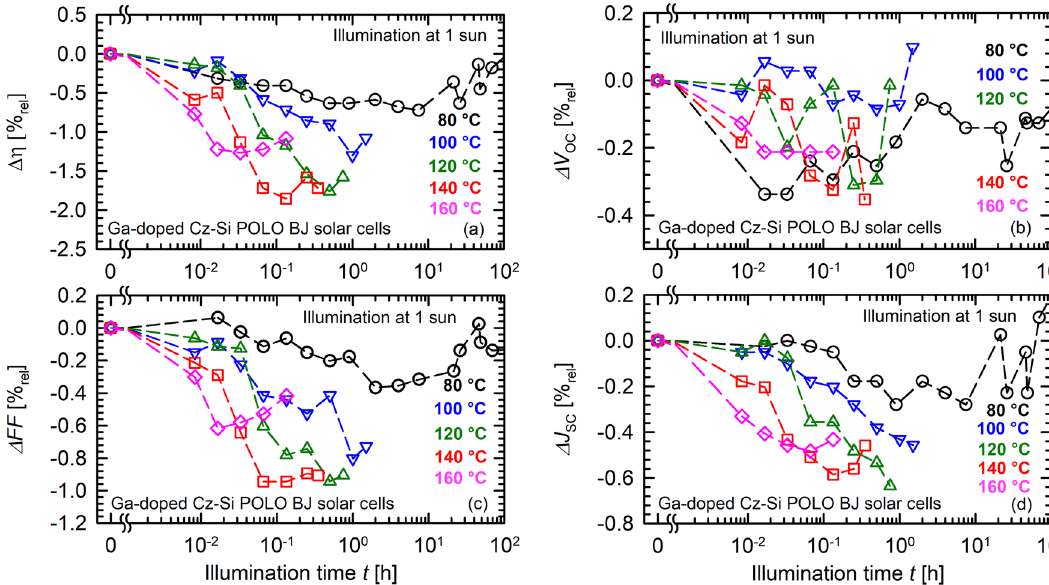
Figure 3. Temperature-dependent light-induced degradation of Ga-doped Cz-Si POLO BJ solar cells at 1 sun light intensity and temperatures ranging from 80 to 160 °C. Shown are the relative changes in the measured cell parameters ( a ) energy conversion efficiency η, ( b ) open-circuit voltage V OC , ( c ) fill factor FF , and ( d ) short- circuit current density J SC versus the illumination time t .